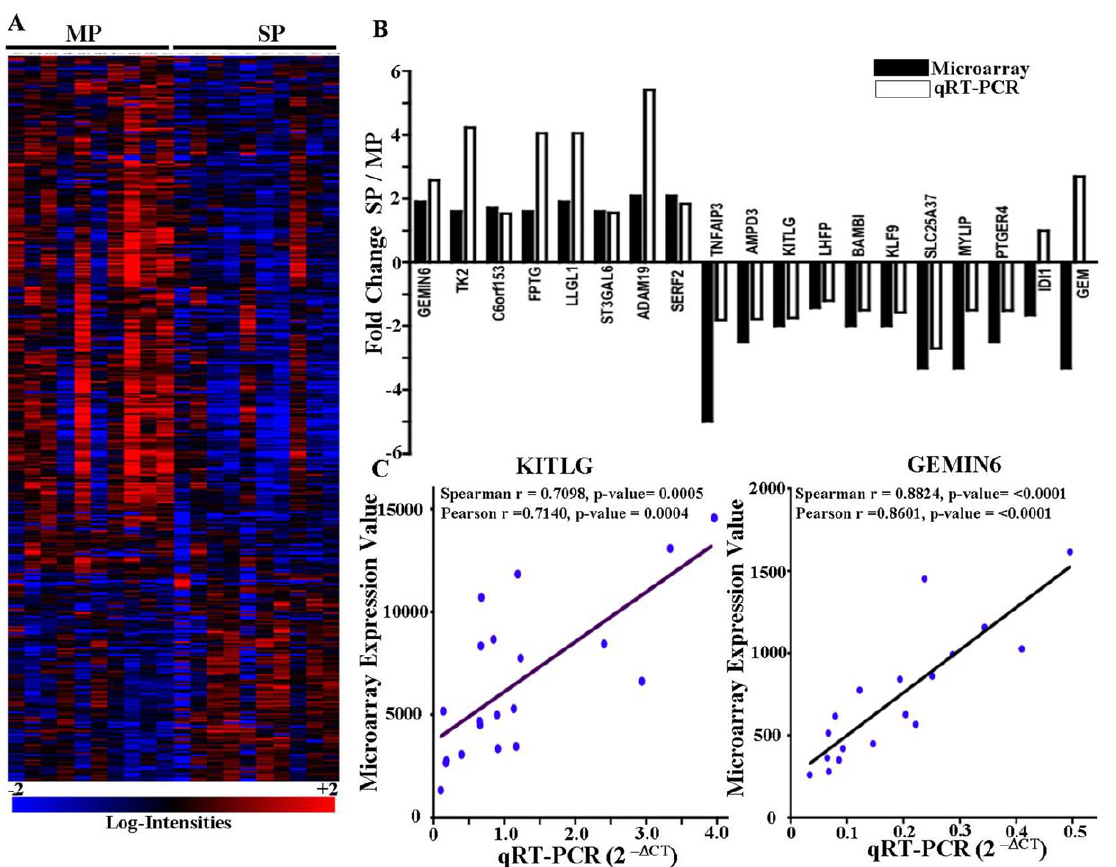
Figure 1. Expression profiling of SP/MP cells from ascites specimens. (A) Heatmap showing the expression pattern of 438 probesets that discriminated SP cells from MP cells in ovarian cancer patients. Vertical columns represent individual samples; horizontal rows represent individual genes. The red and blue color indicates up and down-regulation respectively. (B) Validation of microarray data using qRT-PCR: 19 randomly selected genes were used to validate the microarray data. To calculate the relative expression for each gene, the 2 2 DD CT method was used averaging the CT values for the three housekeeping genes (Cyclophilin A, GUSB, GAPDH) for a single reference gene value. (C) Representative plots for correlation analysis between the microarray and qRT-PCR data: The 2 2 D CT values (qRT-PCR) were plotted against signal intensity values (Microarray). The correlation analysis was performed for each gene by Pearson’s and Spearman’s method using GraphPad Prism version 4.00.